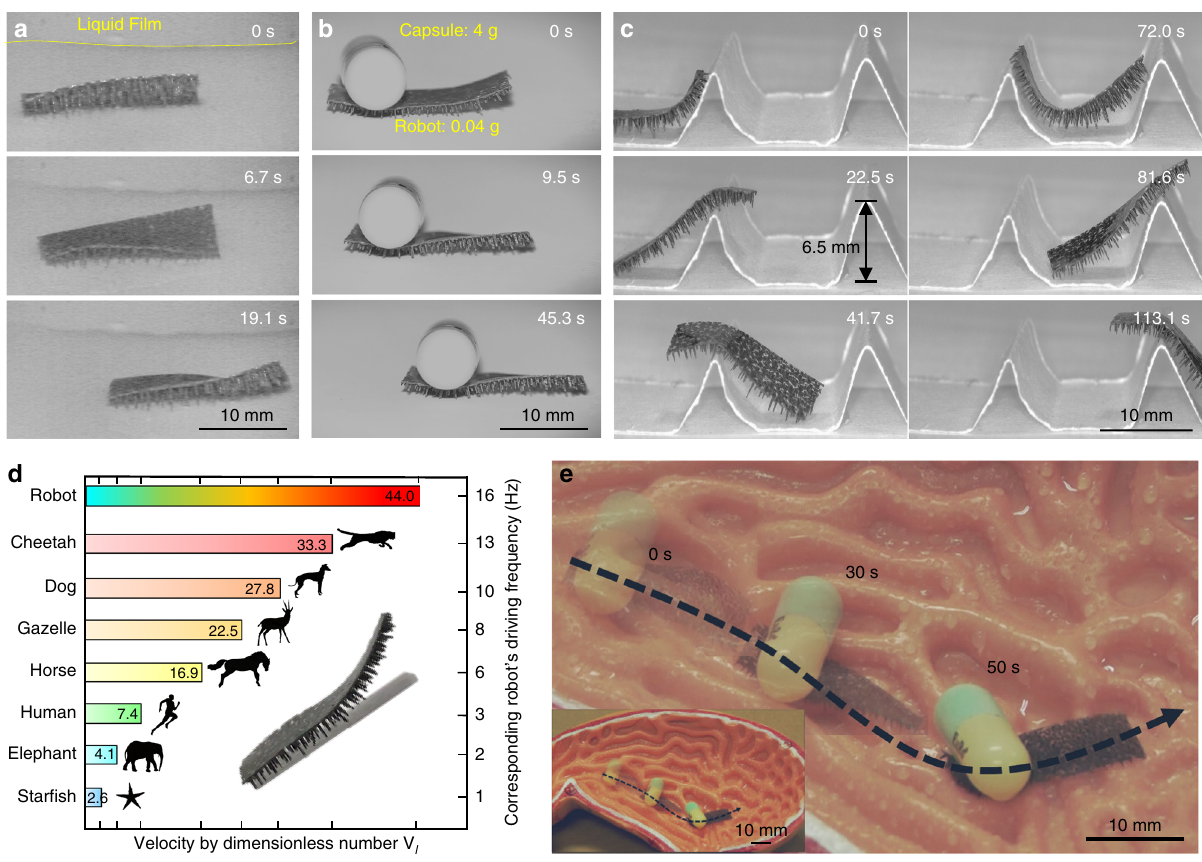
Fig. 4 Demonstration of robot locomotion at harsh environment. a Locomotion on wet surface with liquid fi lm. The robot can move with an average speed of 0.5 mm/s on wet surface under a drive frequency of 1 Hz owing to its small contact area to underlying substrate and hydrophobic tapered feet. b Robot locomotion with a loading 100 times of its own weight. In this condition, the robot can move 8 mm in 45 s. c Cross a steep obstacle with height ∼ 10 times higher of its own leg. The robot ’ s posture can be easily adjusted to climb obstacles as a result of the discontinuous fl ap-wave mode and continuous inverted-pendulum motion locomotion mode. d Comparison of the normalized speed between the soft robot and other animals. A dimensionless number V fi ned to quantify the locomotion ef fi ciency of various living l , i.e., the locomotion distance in one second relative to the lower limb (leg or foot) length, is de organisms. The maximum velocities of human and cheetah are 10.4 m/s and 33.3 m/s, respectively, corresponding to V l 7.4 and 33.3, respectively. In contrast, the soft robot can easily reach the maximum speed of human and cheetah at a swing frequency 3 Hz and 13 Hz, respectively. e Demonstration